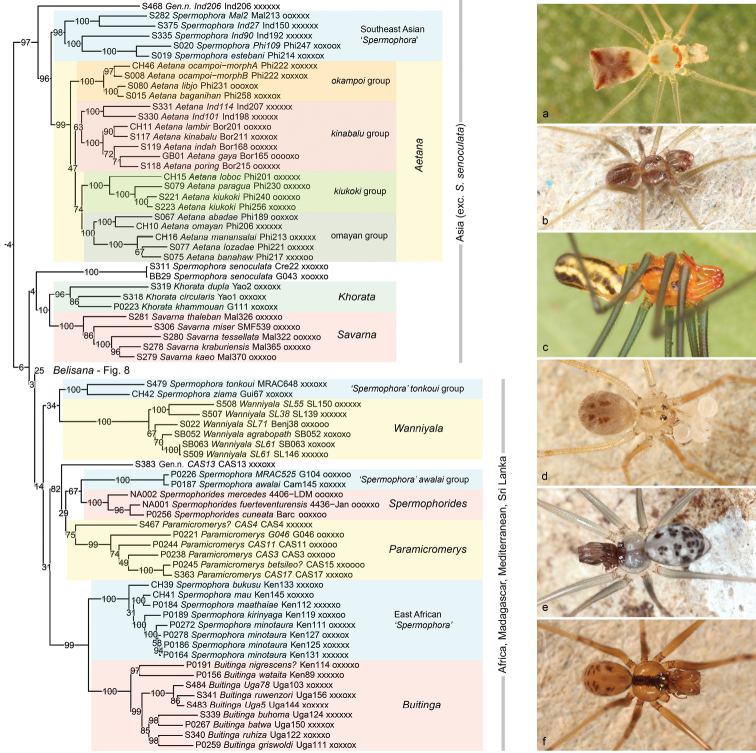
Pholcinae ‘group 1’ (Spermophora and relatives) a Gen. n., sp. n. “Ind206” (Halmahera); b‚ Spermophora sp. n. “Ind27” (Sumatra) cAetanabaganihan (Philippines) dSpermophorasenoculata (Turkey) eSavarnatessellata (Thailand) fWanniyalaagrabopath (Sri Lanka).